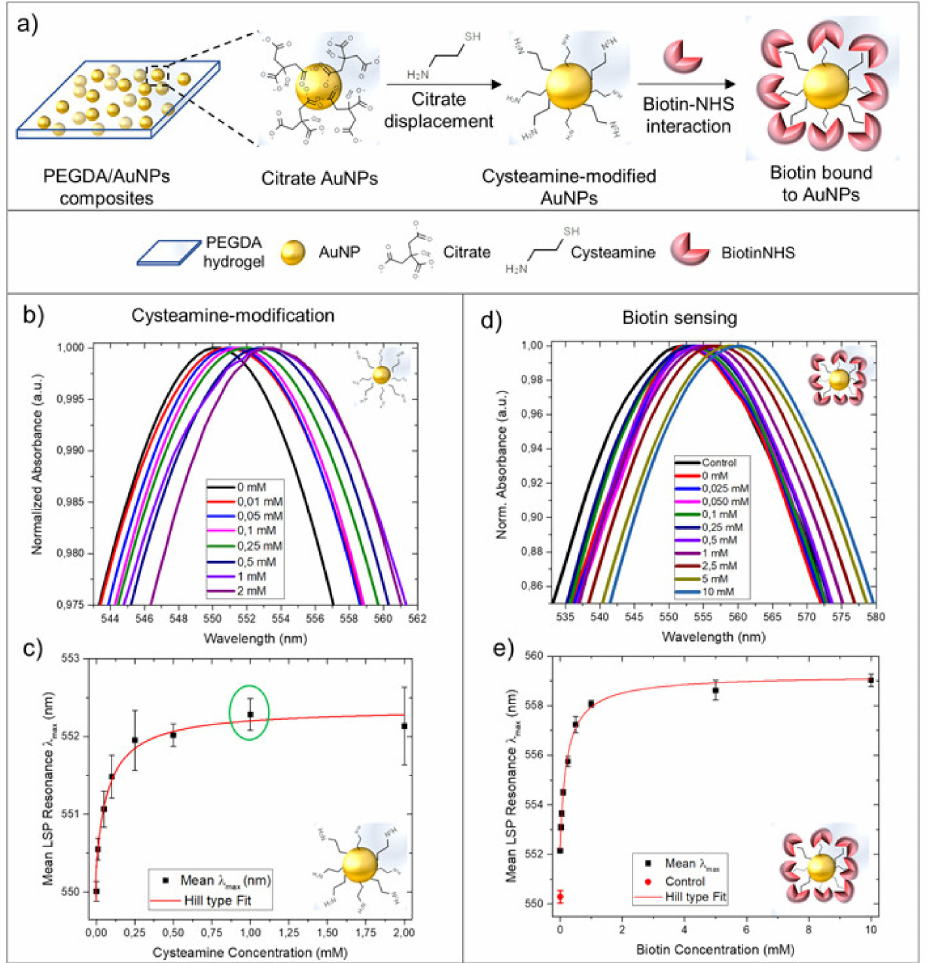
Figure 13. Biotin detection with poly(ethylene glycol)-based embedded with gold nanoparticles (PEGDA/AuNPs). ( a ) The preparation process of hydrogel PEGDA/AuNPs, modification of gel trapped nanoparticles involves the citrate displacement with a cysteamine modification of Au and the biotin grafting on the available amino groups of cysteamine. ( b ) Absorbance spectra of the hydrogel as a function of cysteamine concentration. ( c ) Shift of λ max as a function of the cysteamine concentrations from 0:01 to 2 mM; ( d ) Absorbance spectra of the hydrogel as a function of biotin concentration ranging from 25 µ M to10 mM. ( e ) Shift of λ max as a function of the biotin concentration (from 25 µ M to 10 mM). Reprinted with permission from [36]. Copyright 2021 AIP